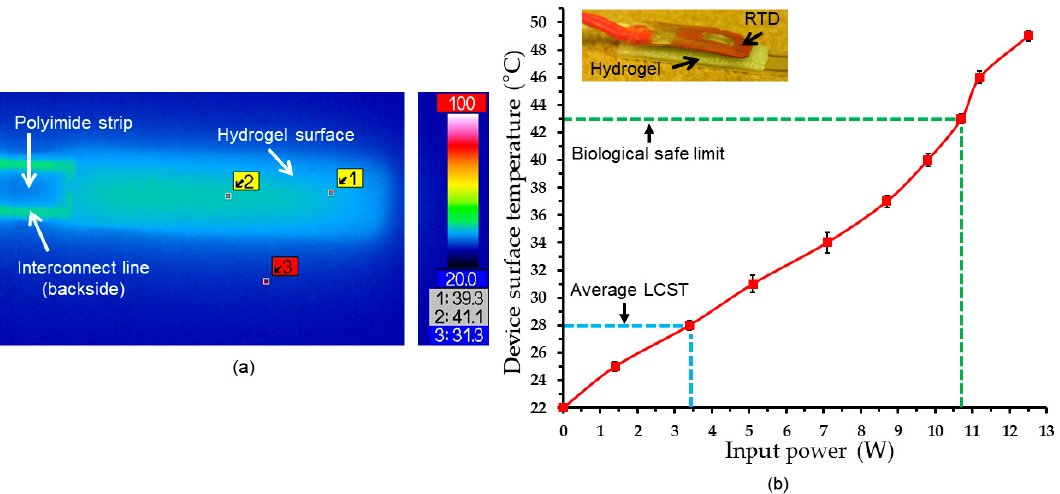
Figure 6. Electrothermal characterization of the active tip: ( a ) An infrared (IR) image showing surface temperatures of the swelled PNIPAM hydrogel in air; ( b ) device surface temperatures vs. input power to the built-in heater measured in water (insert image showing the device attached with the resistance temperature detector (RTD) used for the measurement).